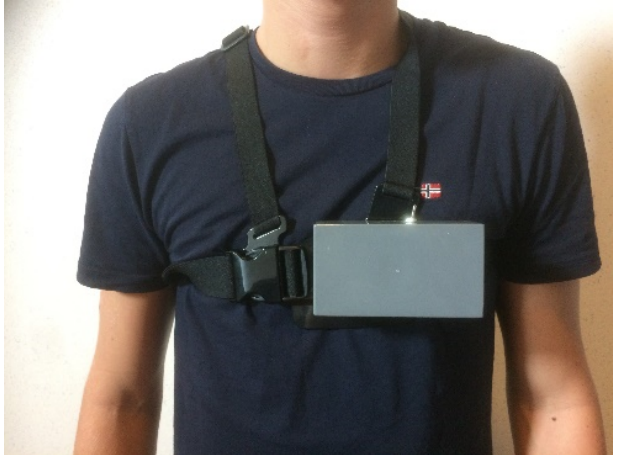
Figure 2. Ambient conditions box with temperature and humidity sensors and data receiver and and storage.